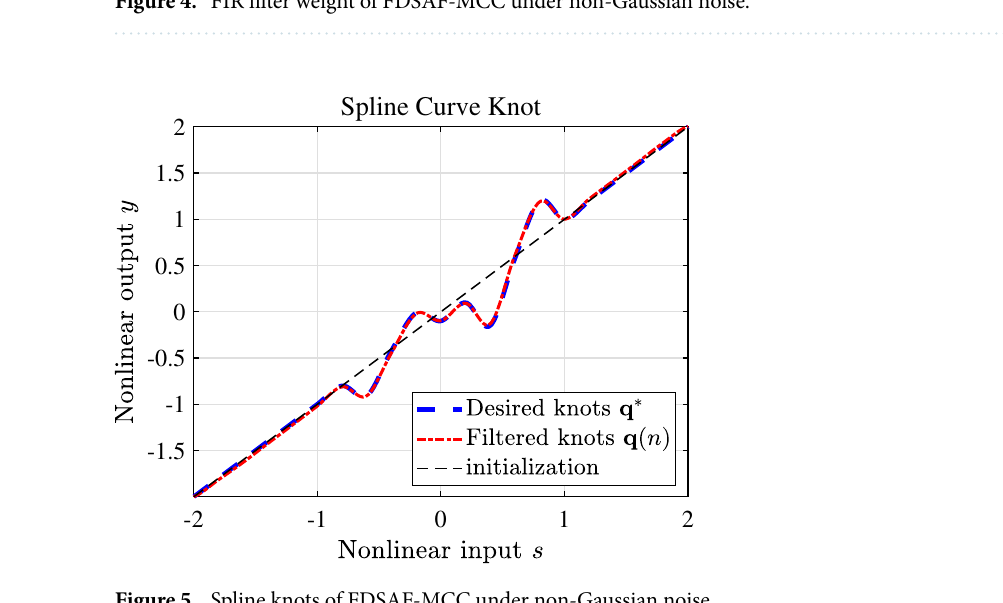
Figure 5. Spline knots of FDSAF-MCC under non-Gaussian noise.